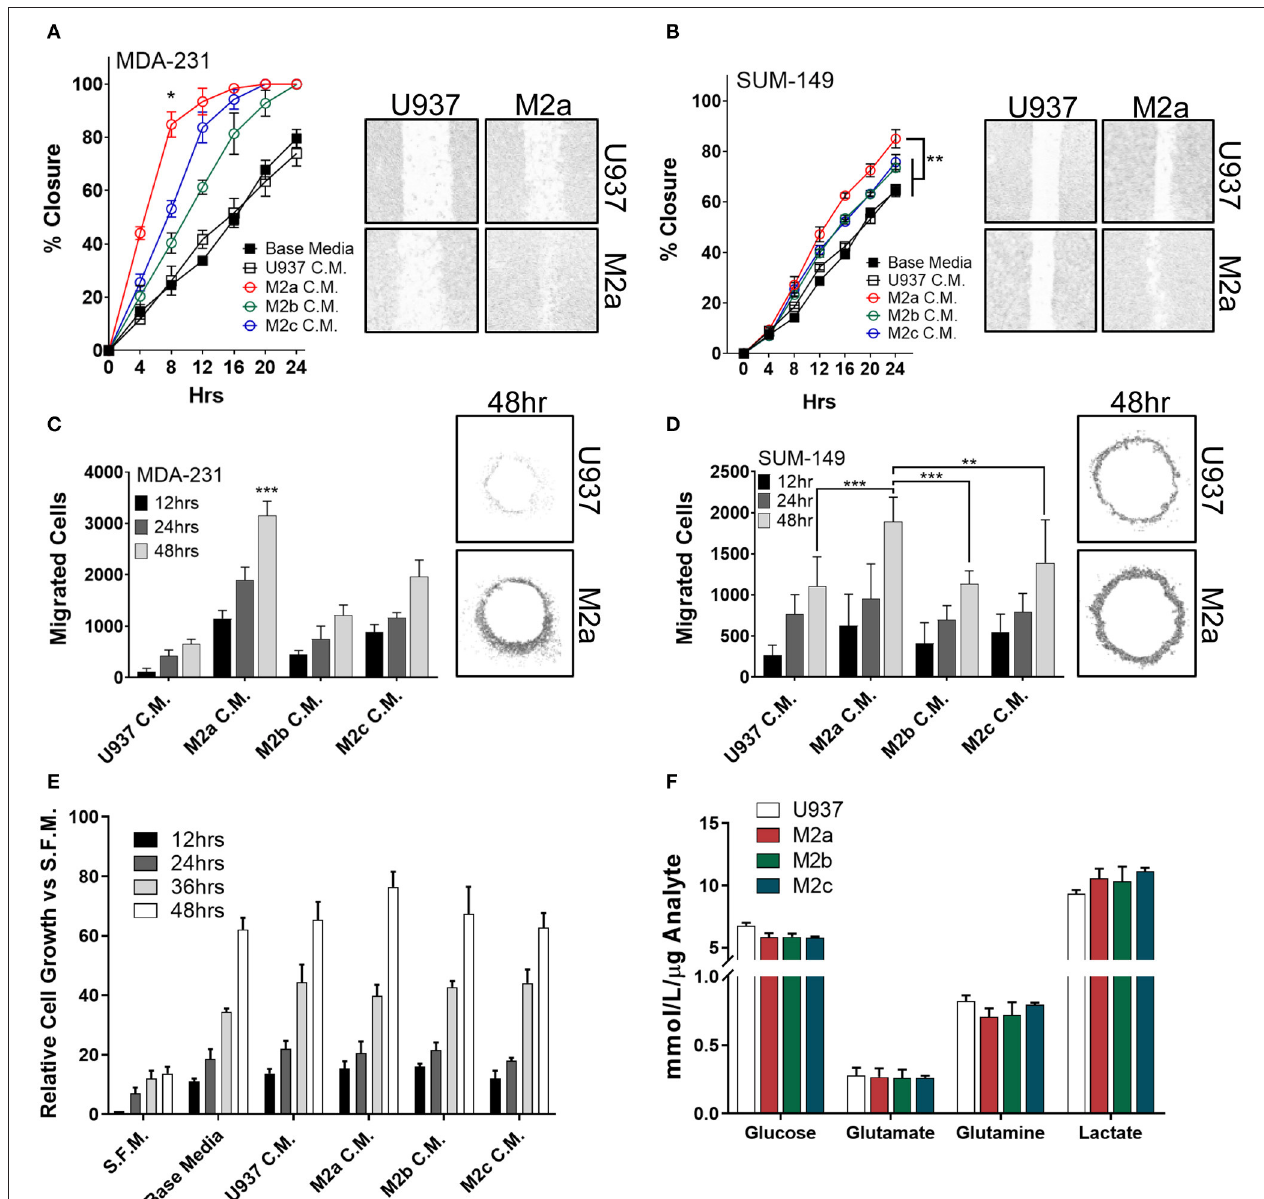
FIGURE 1 | M2a macrophage conditioned media is a potent inducer of breast cancer cell 2D migration. Results from scratch wound migration assays display M2a conditioned media elicits a significantly greater migratory response in MDA-231 cells (A) and SUM-149 cells (B) . Similar results observed in a modified donut cell migration assay in MDA-231 (C) and SUM-149 cells ( D) ; 48h post M2a C.M. addition in MDA-231 cells is statistically significant to all other 48h time points, p < 0.001 (C) . The three M2 macrophage conditioned medias do not alter cellular growth rates in MDA-231 cells (E) . Results from YSI metabolite analysis display no changes in key metabolic analytes among the three M2 macrophages (F) . All results are compiled from ≥ 2 independent experiments; error bars represent ± standard deviation; Statistical significance determined by one-way ANOVA; p -value is displayed as * p < 0.05, ** p < 0.01, *** p < 0.001.